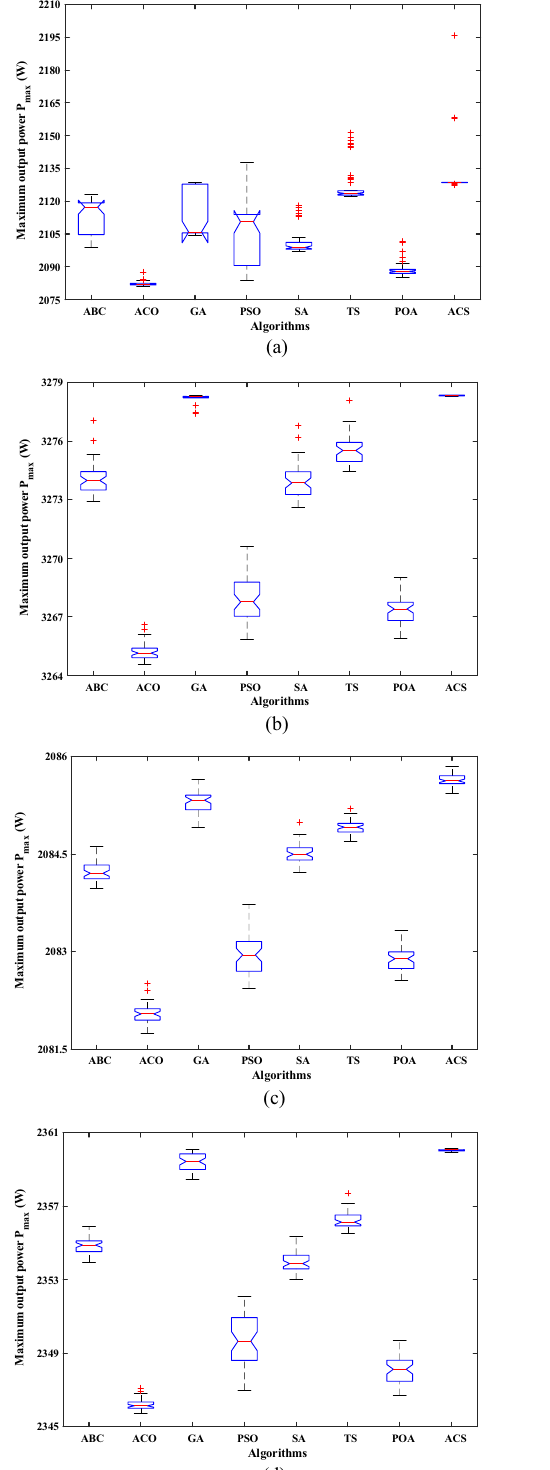
Fig. 12 Convergence curves of eight algorithms under four different scenarios of (20 15) TEG system: a diagonal, b outer, c inner, and d × random